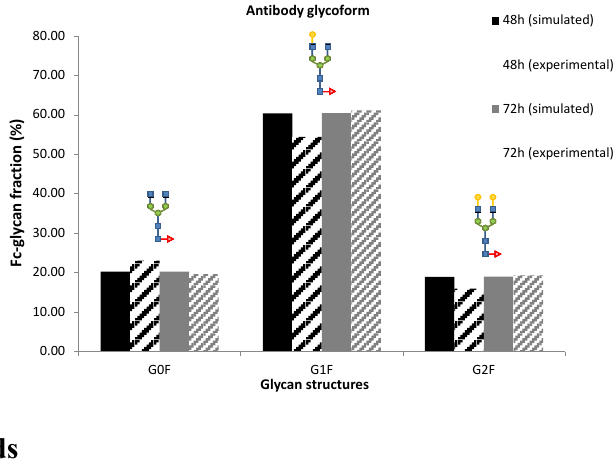
Figure 7. Simulated and experimentally determined distribution of the cumulative N -linked glycoform of the antibody Fc region for two time points during cell